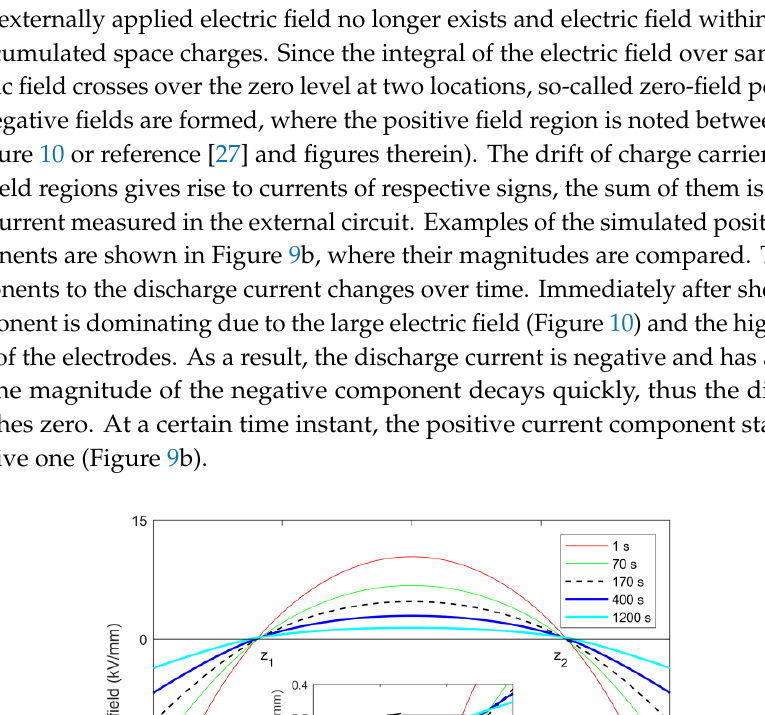
Figure 10. Temporal distributions of simulated electric field in pure LDPE during discharging stage at 80 °C: z 1 and z 2 are the zero-field points. The inset and its arrows show the temporal displacement of the left zero field point ( z 1 ).